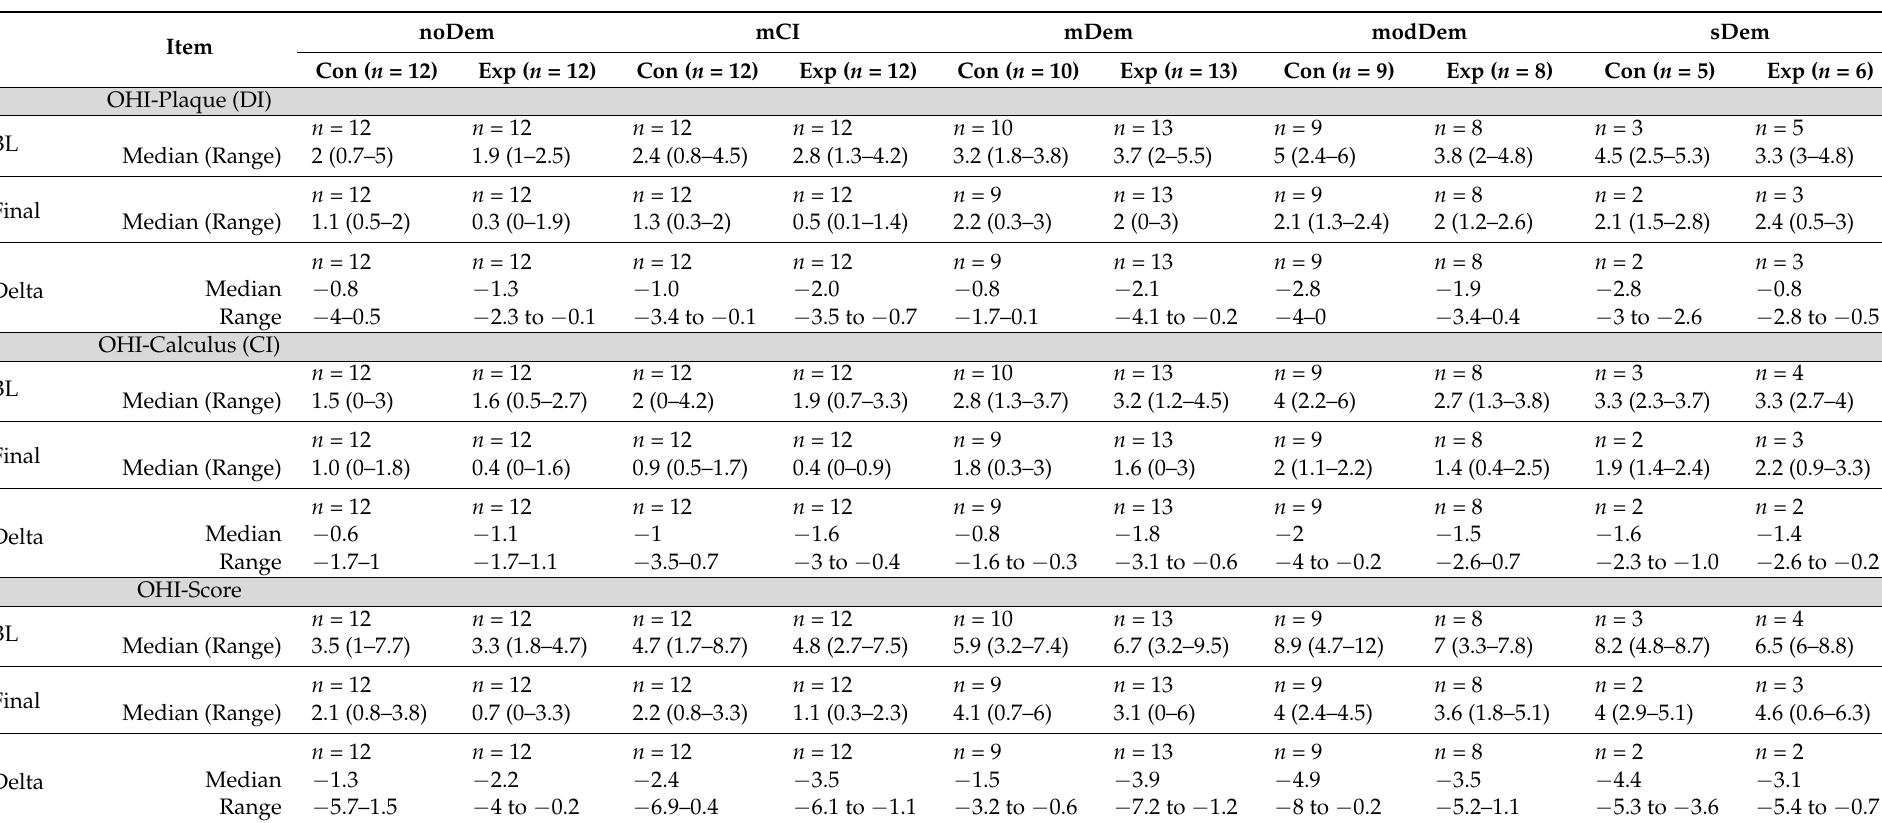
Table 4. Oral hygiene index (OHI) and its components (DI: debris index; CI: calculus index) and ∆ OHI Calculus, ∆ OHI Plaque, and ∆ OHI Score, separated by mini mental state examination (MMSE) group and subgroup (control/experimental group) (evaluation time point—BL: baseline; Final (12 months after BL))